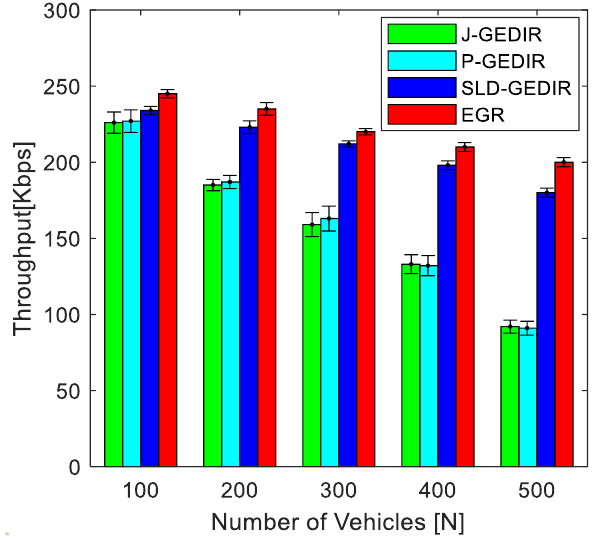
Figure 15. Effect of vehicle density on throughput.